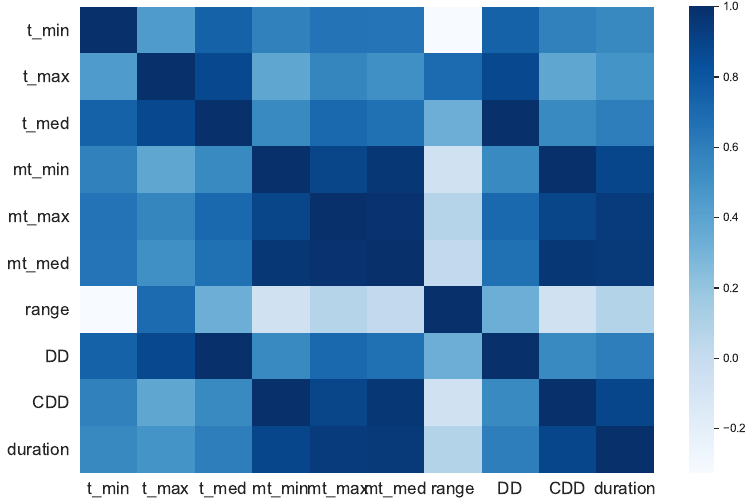
Figure 6. Feature correlation